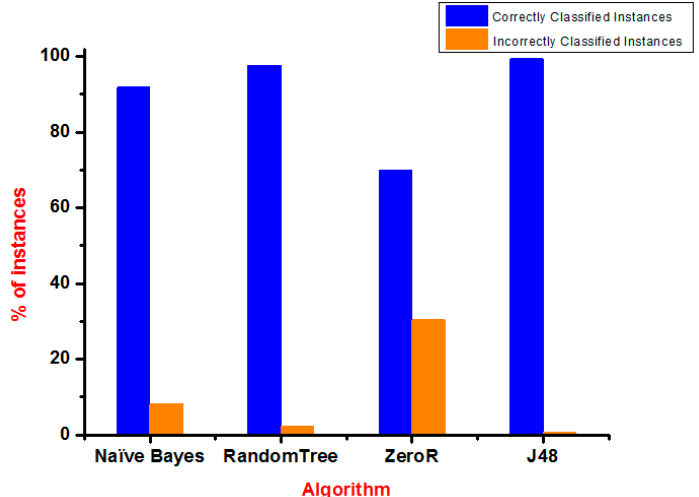
Figure 10. The graph of correctly and incorrectly classified instances of algorithms.